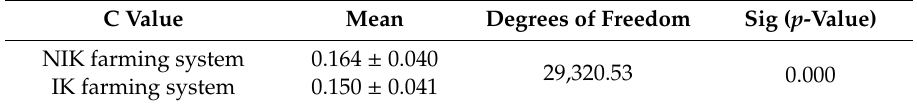
Figure 3. The component factors of Universal Soil Loss Equation (USLE) in Song Kon commune: ( a ) Location of hydrometeology stations, ( b ) R factor, ( c ) K factor, ( d ) LS factor, ( e ) C factor, and ( f ) P factor. Table 4. The di ff erence of C value between IK and NIK farming systems in acacia planting